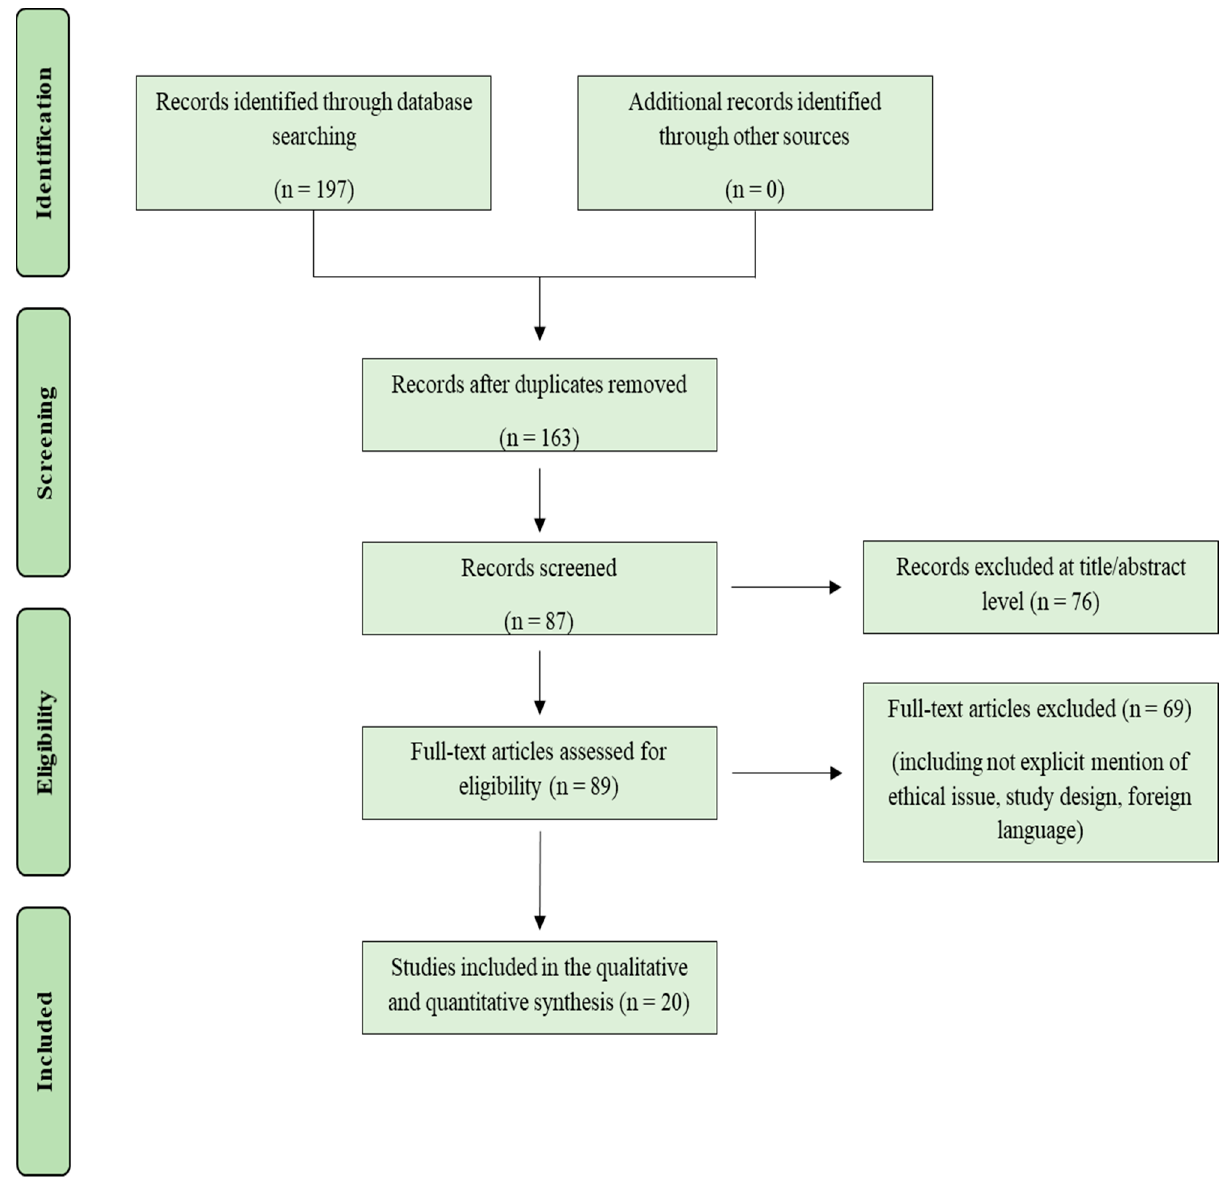
Figure 1. Search strategy following PRISMA standards, including an evaluation of bias.